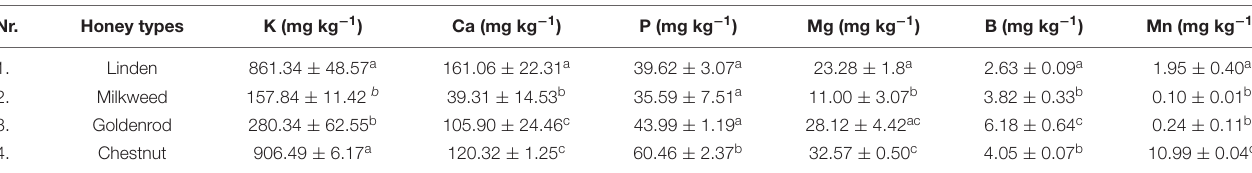
TABLE 4 | Element content of the studied honey